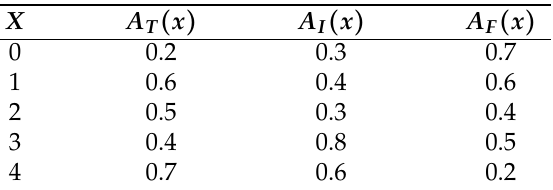
Table 4. Tabulation representation of A = ( A T , A I , A F )